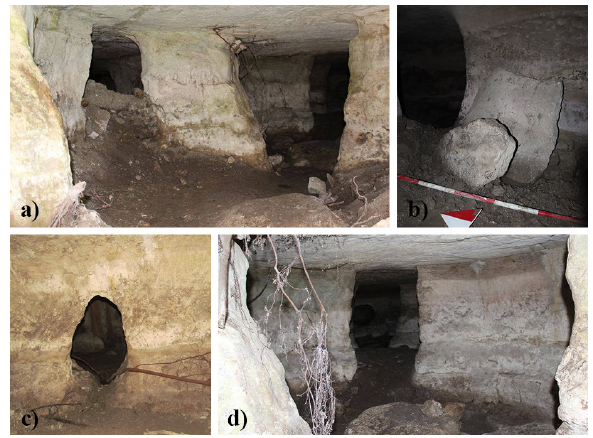
Figure 4 . Architectural features: openings between the rooms and door slabs.